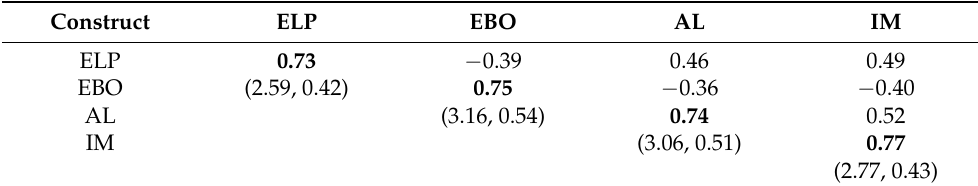
Table 5. Correlations and discriminant